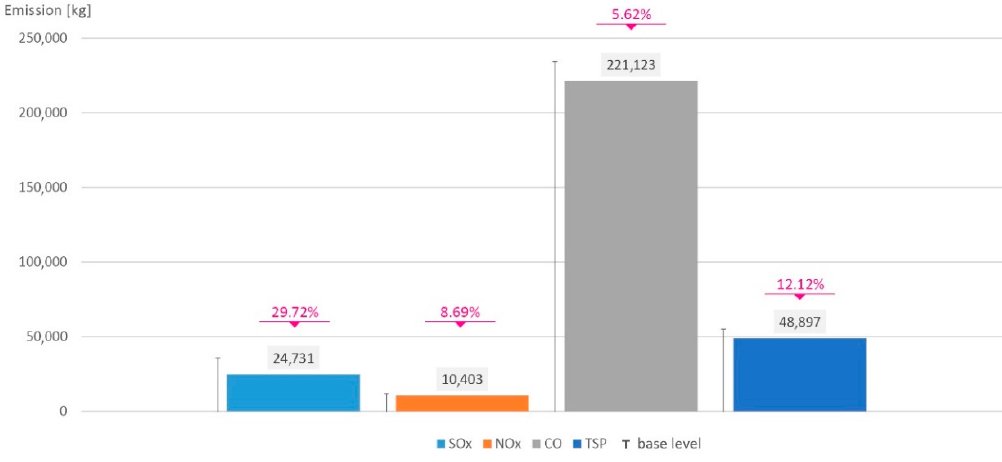
Figure 9. Annual emissions of pollutants in Model 3: 47.5% coal, 47.5% biomass, 5% fuel oil.